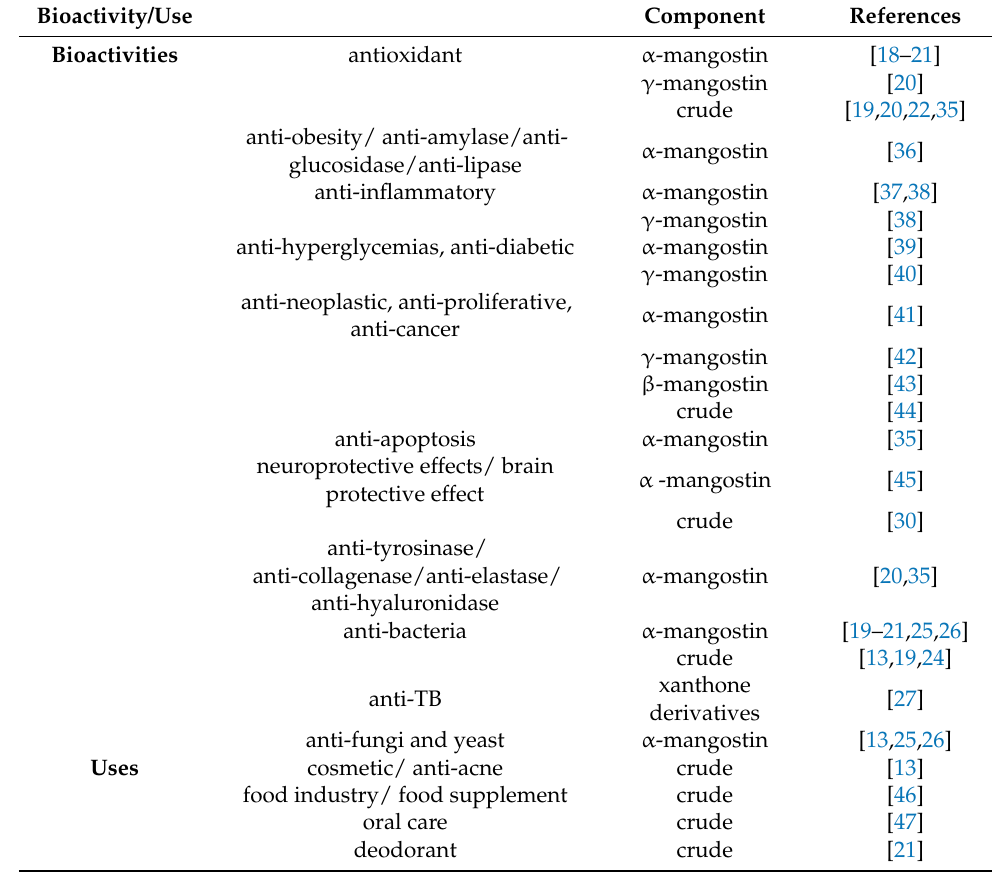
Table 1. The bioactivities of xanthones and common uses of mangosteen pericarps